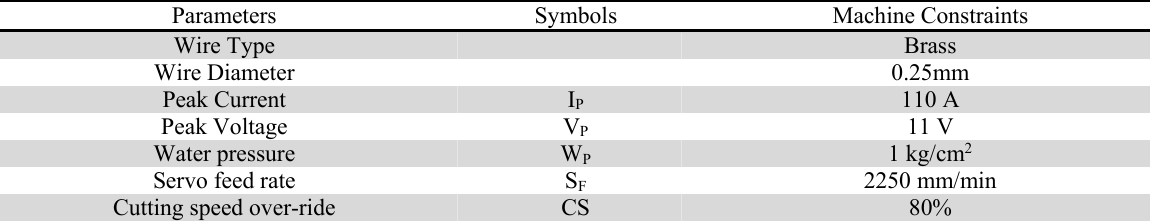
Fixed parameters used in the